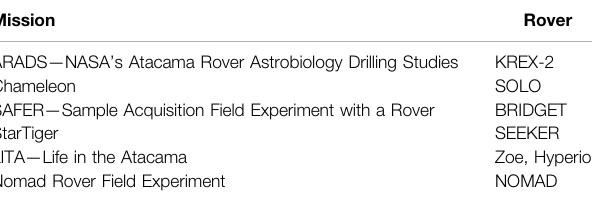
TABLE 2 | Field-tested Robotic missions in the Atacama